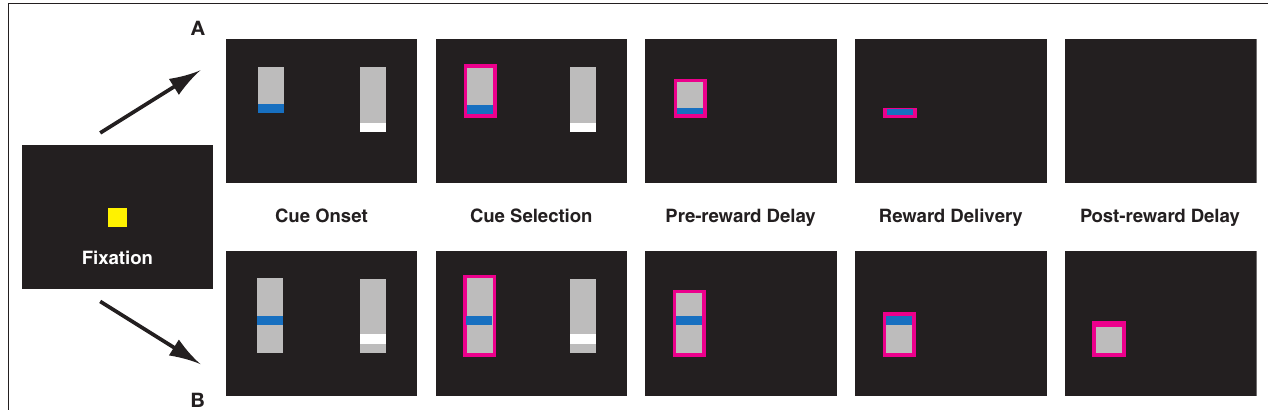
unselected cue vanished and the bar corresponding to the chosen option shrank at a fixed rate. Reward was delivered when the top of the bar reached the colored stripe. In the uncued paradigm, the screen remained blank through the post-reward delay. In the cued paradigm, the remaining bar corresponded to the post-reward delay and continued to shrink through the end of the